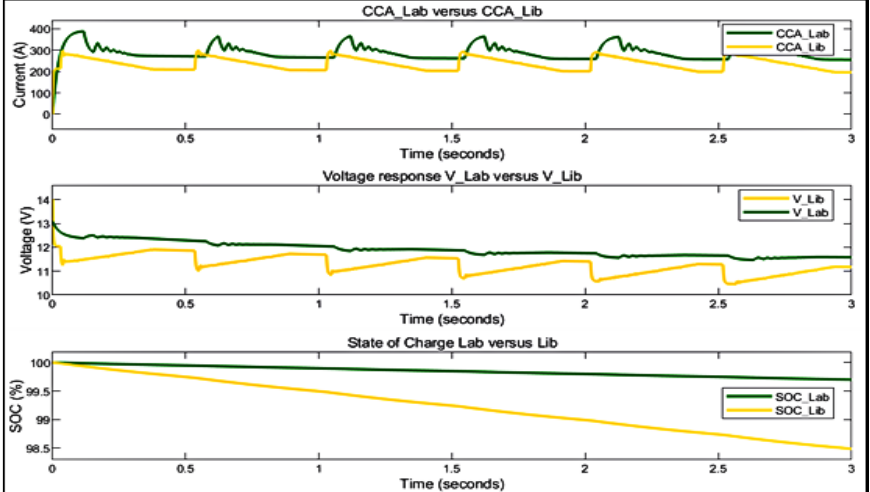
Figure 19. The supplied required CCC, SoC and voltage response of HESS for case three (b) during discharge mode.